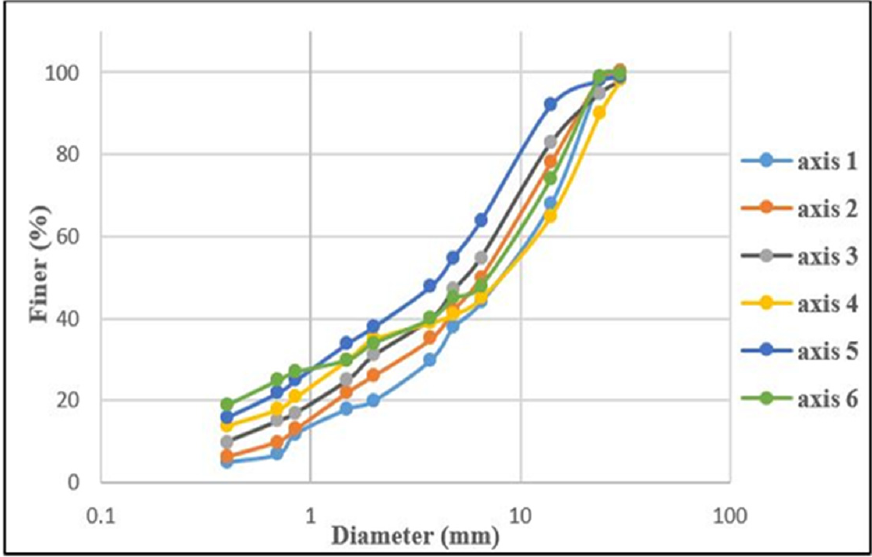
vided into 4 to 5 equal subsections. In each subsection, bed load sampling measurements